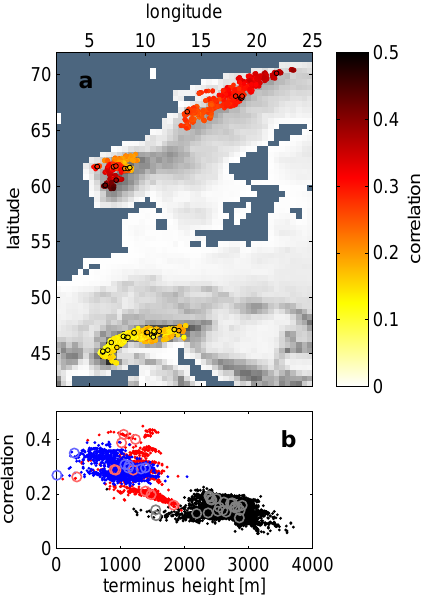
Fig. 9. Correlation between modelled monthly mass balance anomalies obtained using the full variability in the forcing, and modelled monthly mass balance anomalies obtained using only NAO-related variability in the forcing, i.e., between MB anom and MB NAO . Markers with black circle (a) and circle markers (b) indi- cate the results of the glaciers with more than 12 existing measure- ments of annual mass balance. Values below the 95% confidence interval have been omitted. Gray background shading: topography of the CRU TS 3.0 data. In panel (b) black is for glaciers in the Alps, red for glaciers in southern Scandinavia, blue for glaciers in northern